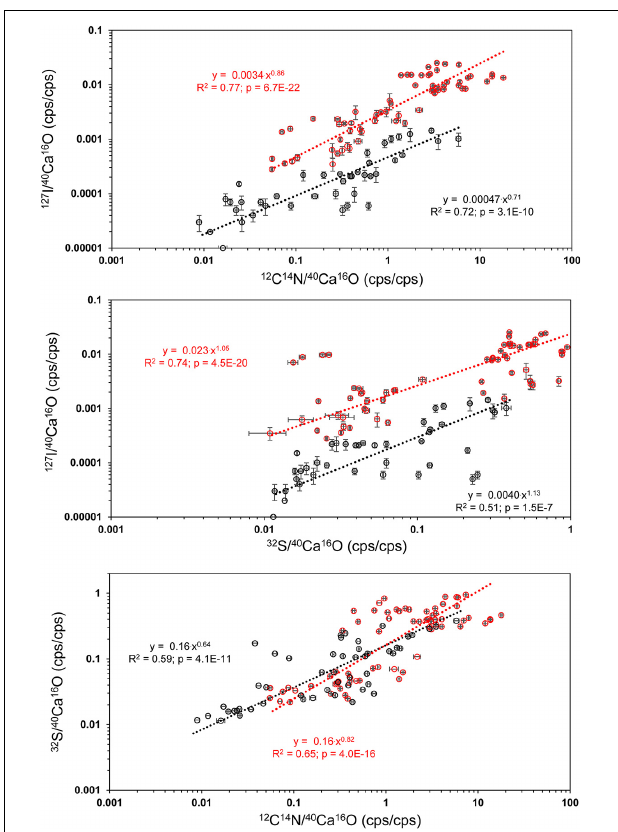
FIGURE 6 | Power regressions between the 12 C 14 N − / 40 Ca 16 O − and 127 I − / 40 Ca 16 O − ratios, between the 32 S − / 40 Ca 16 O − and 127 I − / 40 Ca 16 O − ratios, and between the 12 C 14 N − / 40 Ca 16 O − and 32 S − / 40 Ca 16 O − ratios from all ROIs on all Nano-SIMS element mappings made on U. striata from the Peruvian OMZ. All power regressions show a comparison between cleaned (black) and uncleaned specimens (red). For a summary of all ROIs, see Supplementary Material ( Supplementary Figure S1 ). The reduced major axis (RMA) algorithm was used for the regressions reducing both the x - and y -errors (Warton et al., 2006), due to the independence of both variables. These regressions were performed using the PAST 3 software (Hammer et al.,